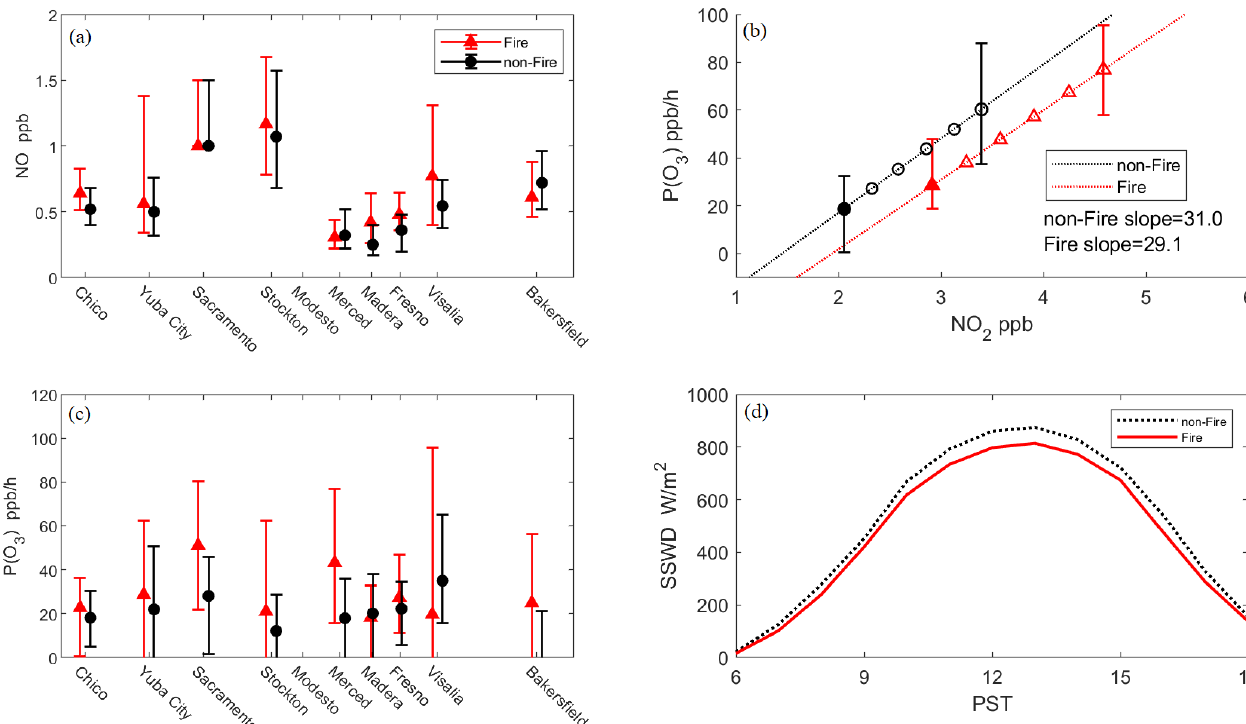
Figure 5. Plots of (a) NO measurements, (b) calculated P(O 3 ) (ppbh − 1 ) at each stage of NO 2 correction (0%–20%–40%–60%–80%, open, and 100%, solid), (c) calculated median PO 3 at each site, and (d) averaged diurnal profiles for SSWD measurements. The error bars in (a) , (b) , and (c) represent the 25th and 75th percentiles for the 5h averaged values between 10:00 and 15:00PST during wildfire days (red) and background days